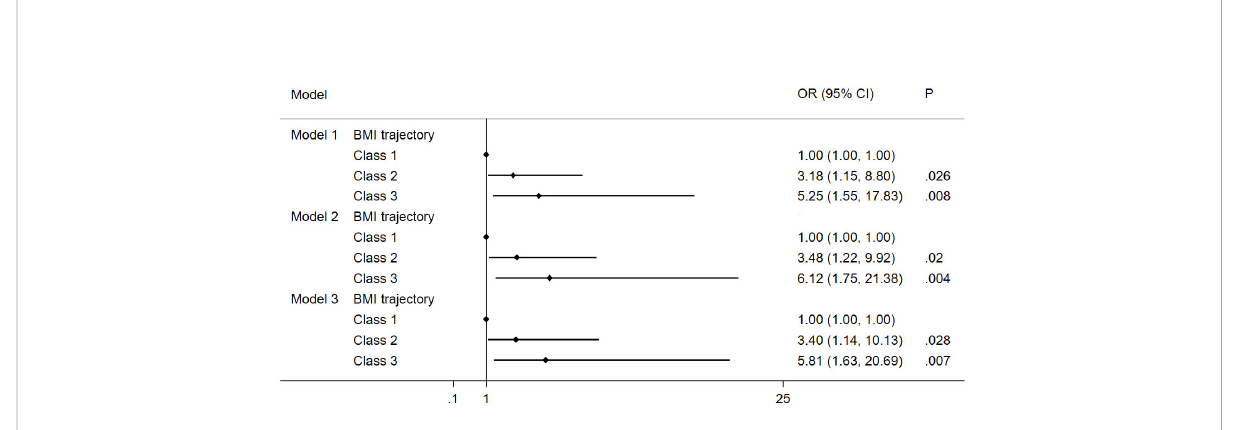
FIGURE 4 Association of MetS and BMI trajectory in the study subjects. Note: Model 1 Adjusted for age, gender, BMI and waist circumference; Model 2 Adjusted for Model 1 and education background, residence, smoker, alcohol consumption; Model 3 Adjusted for Model 2 and energy intake.